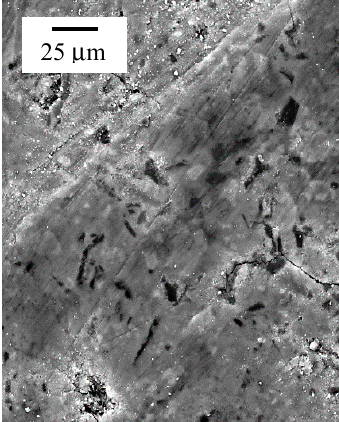
Figure 6. SEM micrograph of cement containing biochar 18% at 1000× magnification.